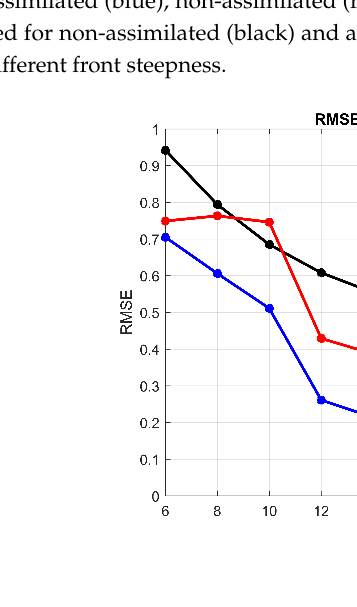
Figure 15. Multiple eddy case of 𝐿 𝑥 = 14 km with noisy parent model (added noise STD = 0.1) and noisy non-assimilated child model (added noise STD = 0.15, bias = 0.3, and shift of 4 km to the west). ( a ) Transects at 𝑦 = 100 km of true field (black), parent (dashed brown), assimilated (blue), and non-assimilated (red) child models, ( b ) RMSE for different eddy sizes and the ratio between them.